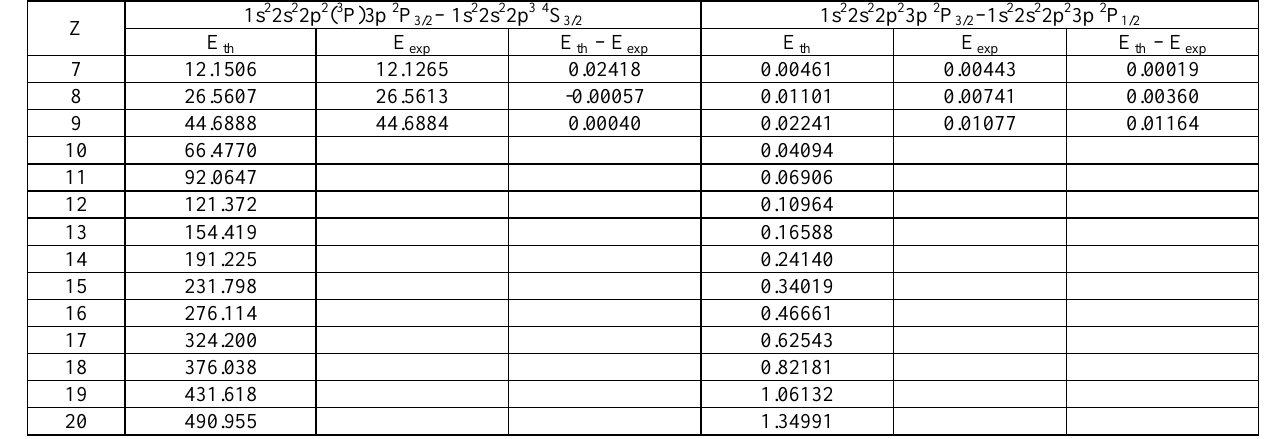
Table 7. Comparison of the calculated energies (in eV) of 1s 2 2s 2 2p 2 ( 3 P)3p 2 P 3/2 states of nitrogen-like ions and fine